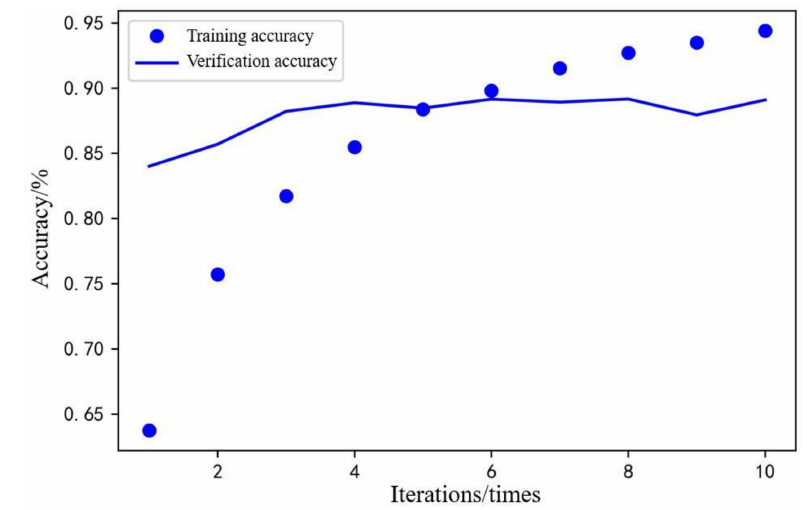
Figure 9. Training accuracy and verification